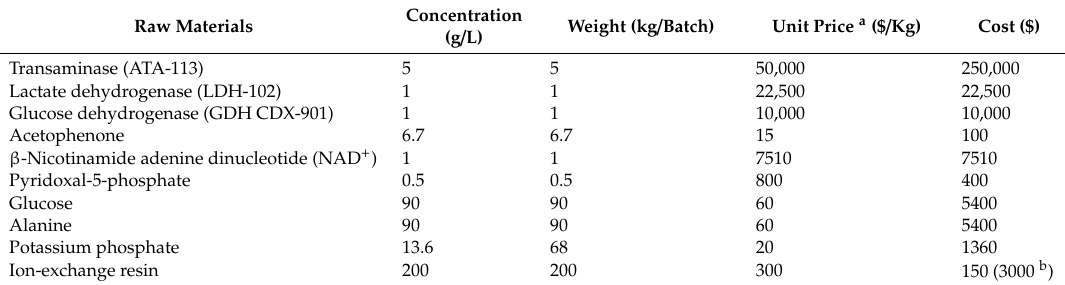
Table 1. Raw material costs per batch of transamination process.